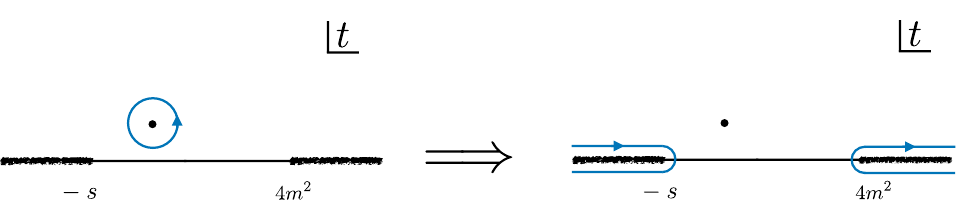
Figure 1. The amplitude is first written as a contour integral and then this contour is deformed to wrap the branch cuts on the real line. We have assumed that the arcs at infinity